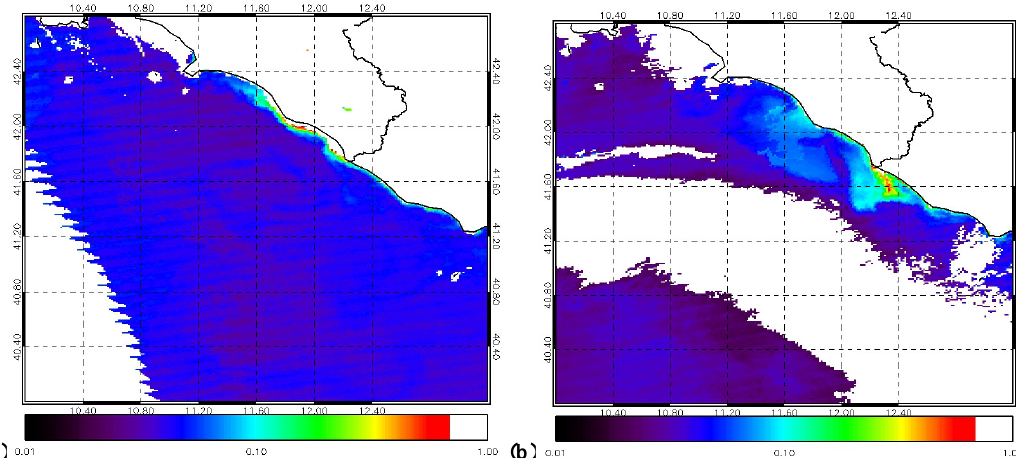
Fig. 10a. 18 July 2010, salinity at –5 m. (b) ( ) Fig. 9. (a) 14 July 2010, map of K490; units (m − 1 ), logarithmic scale. (b) 18 July 2010, map of K490; units (m − 1 ), logarithmic scale. 34 Fig. 9a. 14 Fig. 9b. 18 July 2010, map of K490 ; units ( m − 1 ), logarithmic scale. July 2010, map of K490; units ( m − 1 ), logarithmic scale..